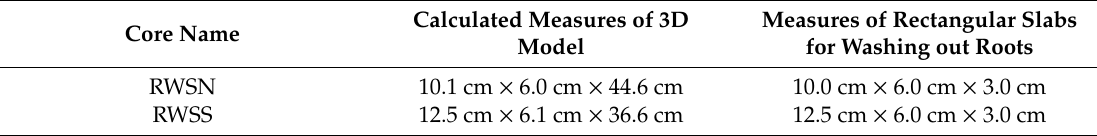
Table A4. 3D model size and slab size for root